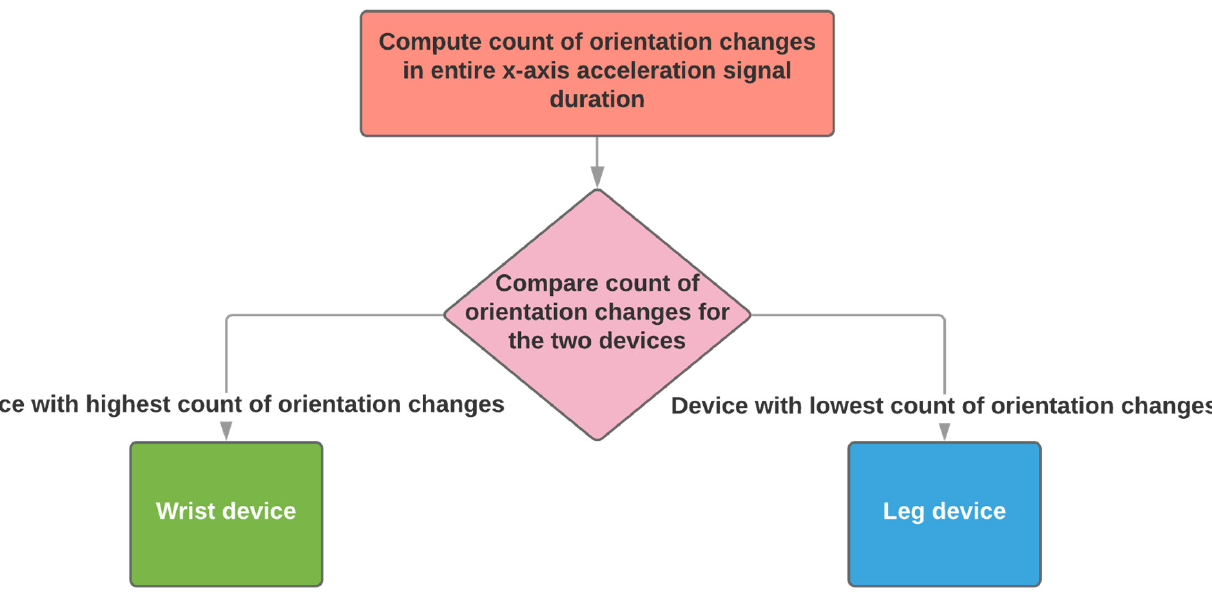
Figure 5. The automatic placement identification algorithm when two sensing devices have been used.